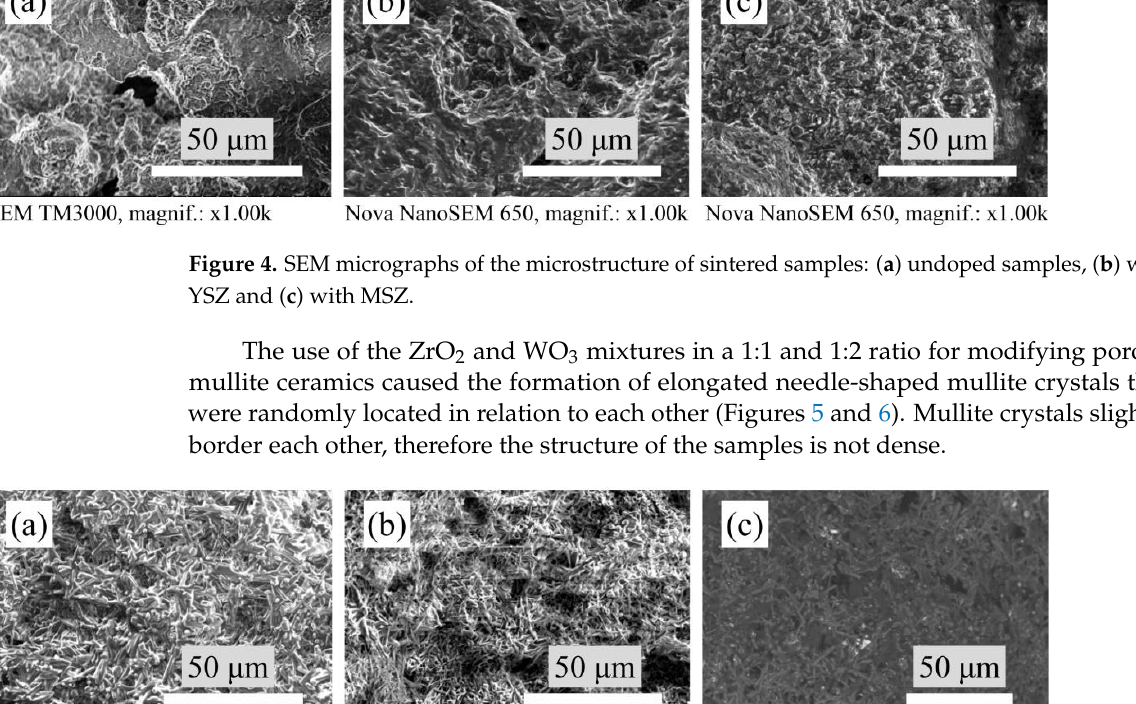
Figure 5. SEM micrographs of the microstructure of sintered samples: ( a ) with YSZ:WO 3 (1:1), ( b ) with MSZ:WO 3 (1:1) and ( c ) with YSZ:WO 3 (1:2).